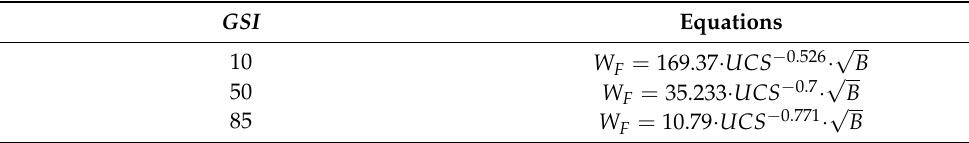
Figure 16. W F graphs based on the UCS , for different values of GSI : GSI = 10; GSI = 50; GSI = 85. Table 4. W F equations based on UCS for different values of GSI